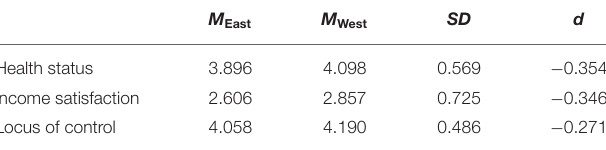
TABLE 5 | Random intercept